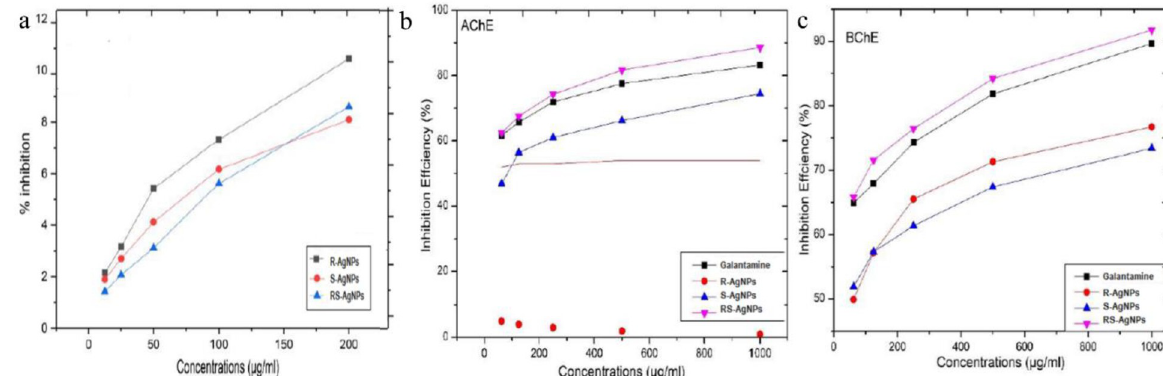
Fig 6. Percent inhibition of α -amylase (a) , acetylcholinesterase (AChE) (b) and butyryl-cholinesterase (BChE) (c) of R-AgNPs, S-AgNPs and RS-AgNPs.